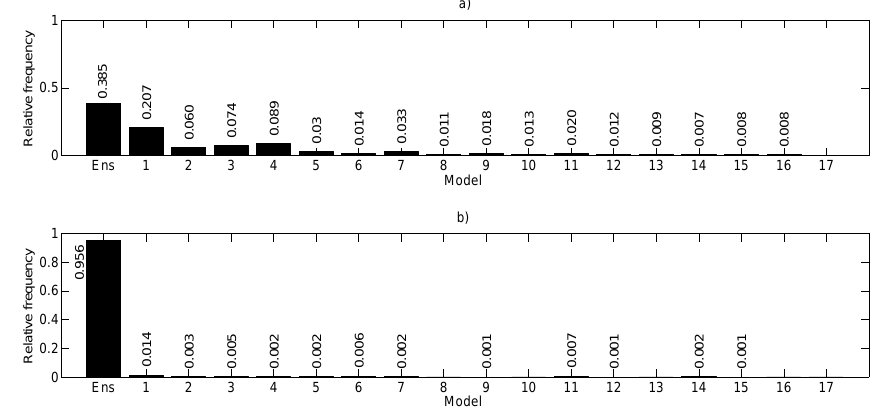
Fig. 4. Relative frequency of occurrence as the best model or ensemble: (a) deterministic (MAE) and (b) probabilistic (CRPS ) .